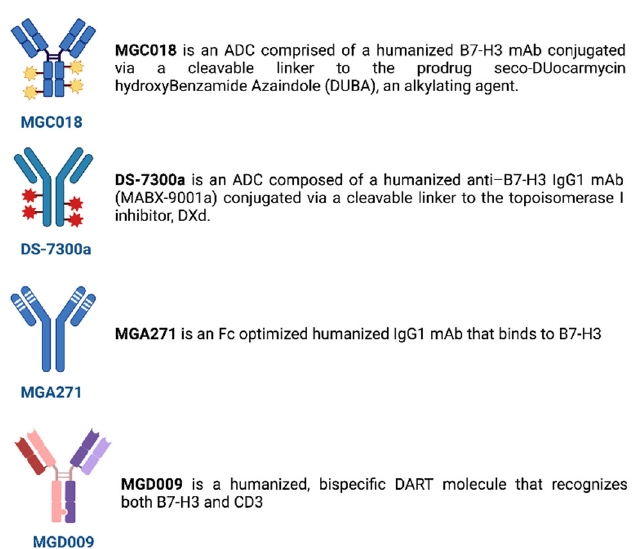
Figure 2. Main B7-H3 inhibitors in solid tumors. ADC: antibody – drug conjugates; mAb: monoclonal antibody; Fc: crystallizable region. antibody; Fc: crystallizable